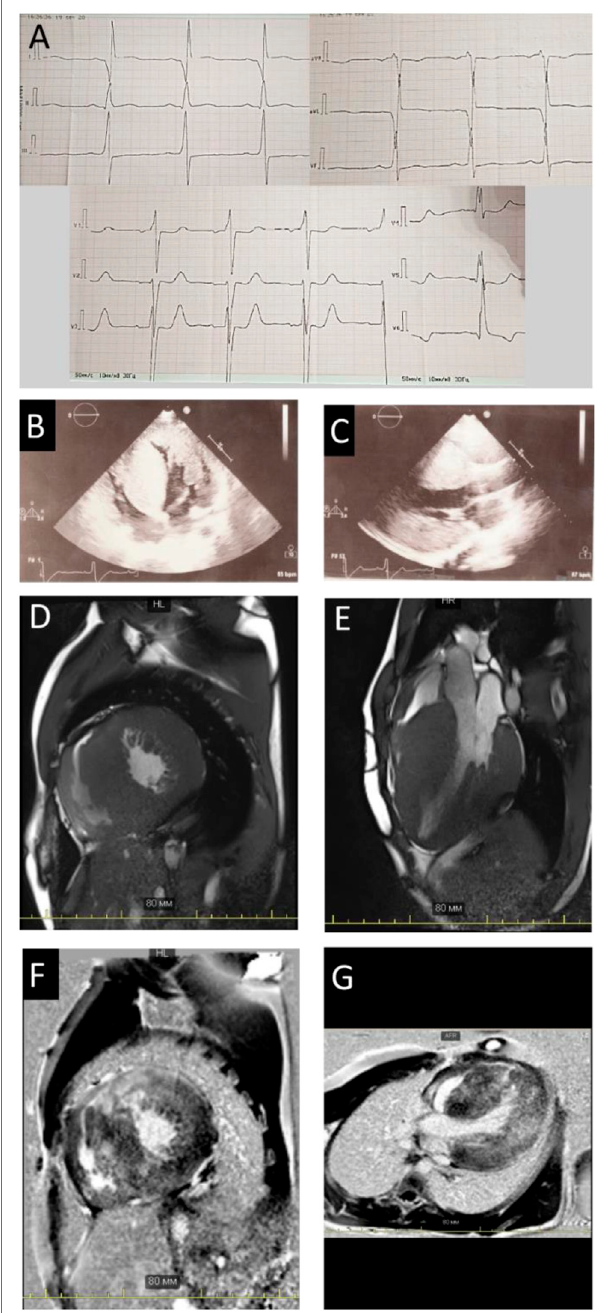
FIGURE1| Instrumental fi ndingsinPatient1.Electrocardiogram (A) and echocardiography picture correspondence to four-chamber (B) view and long-axis view (C) illustrated severe hypertrophy. S ardiac MRI images in the short (D) and long (E) axes, demonstrating wall hypertrophy, limited cavity volume, and late gadolinium enhancement (F,G)